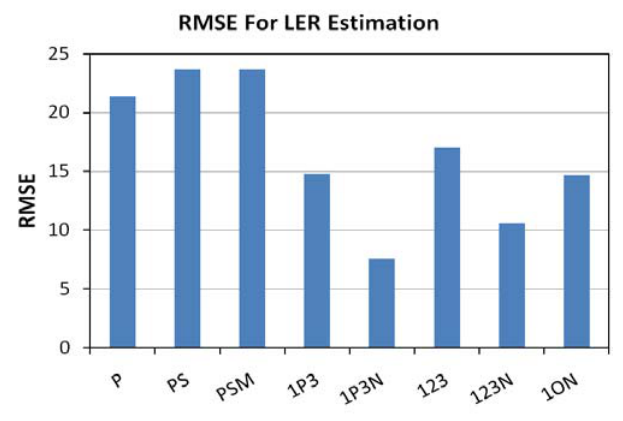
Figure 21. RMSE for LER estimates.